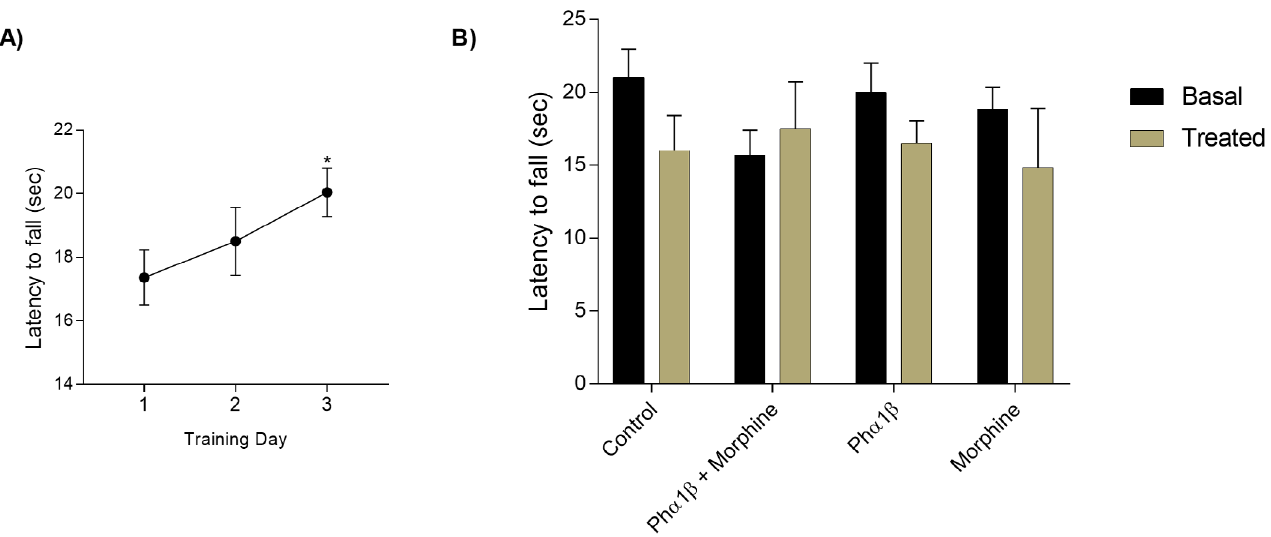
Figure 6. Antinociceptive doses of recombinant Phα1β and morphine (alone or in combination) cause no alterations on forced motor performance in mice. (A) For three consecutive days once a day, mice were placed in a rotating cylinder under constant acceleration in the rotarod device. The average latency time to fall increased along the three days (*p = 0.011 compared to the first day) indicating motor learning. (B) Thereafter, mice that underwent the protocol shown in A were allocated to receive morphine (25 nmol/site), recombinant Phα1β (0.031 nmol/site), or a combination of the two drugs (3.1 nmol/site), doses required to cause 50% of MPE (Table 1). Measurements were made before (black bars) and 30 minutes after (gray bars) treatment. No statistical difference was observed. Data are expressed as mean ± S.E.M. (n = 6 animals per